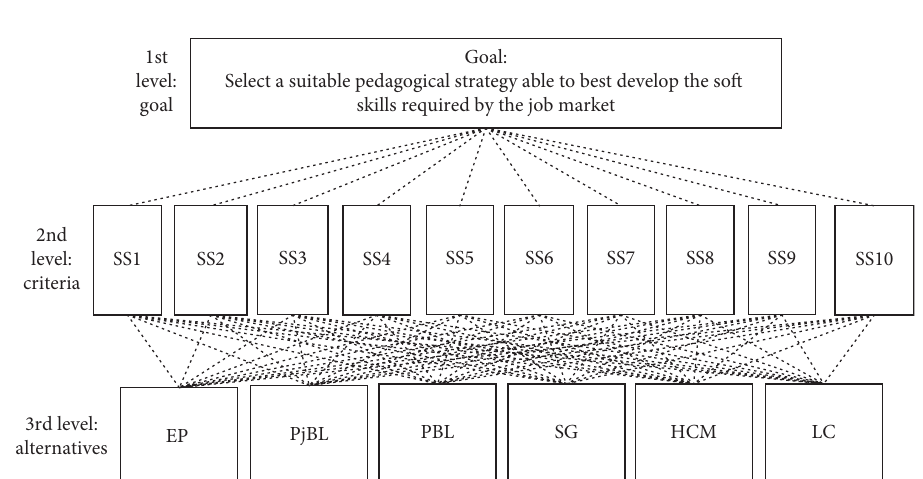
Figure 6: Hierarchical structure of the decision